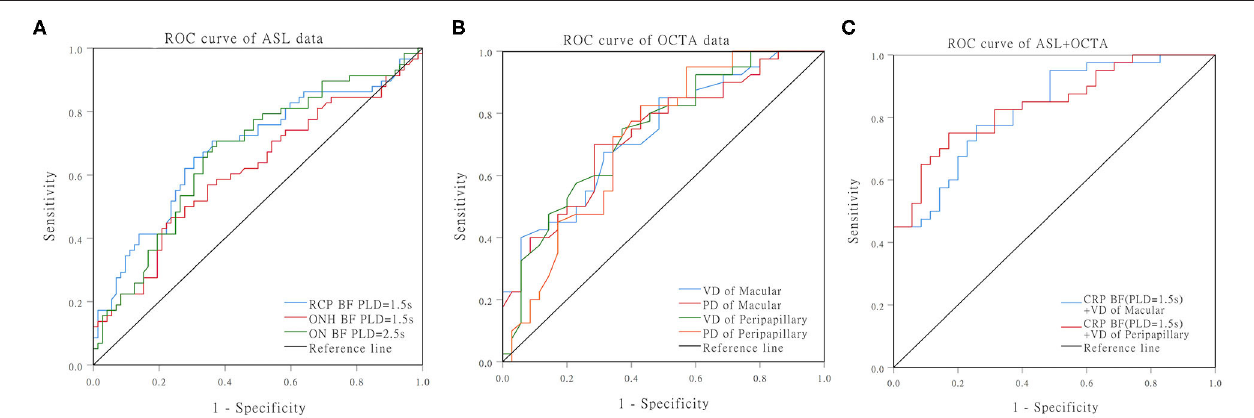
FIGURE 3 | ROC curves for distinguishing PDR from NPDR. (A) ROC curves of the BF of RCP/ONH/ON that were measured by ASL. (B) ROC curves of the VD/PD of the macular/peripapillary areas that were measured by OCTA. (C) ROC curves of the RCP (PLD = 1.5s) BF combined with peripapillary